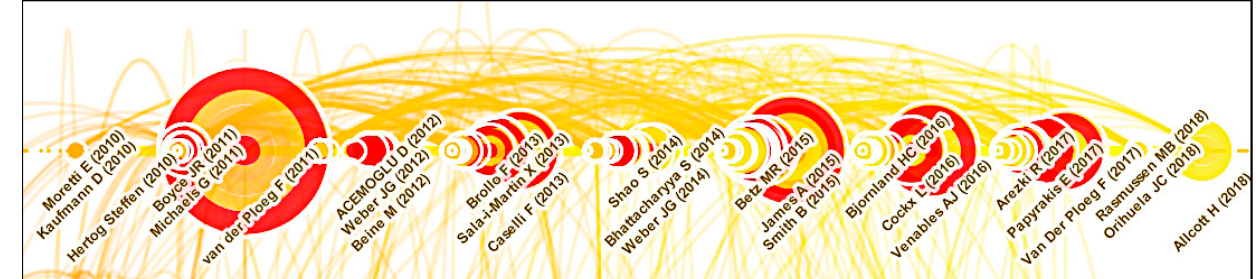
Figure 21 . A timeline visualization of the Cluster 0 co–citation network (using Citespace 5.7.R4). Table 6. Exploration and summary of Cluster 0.